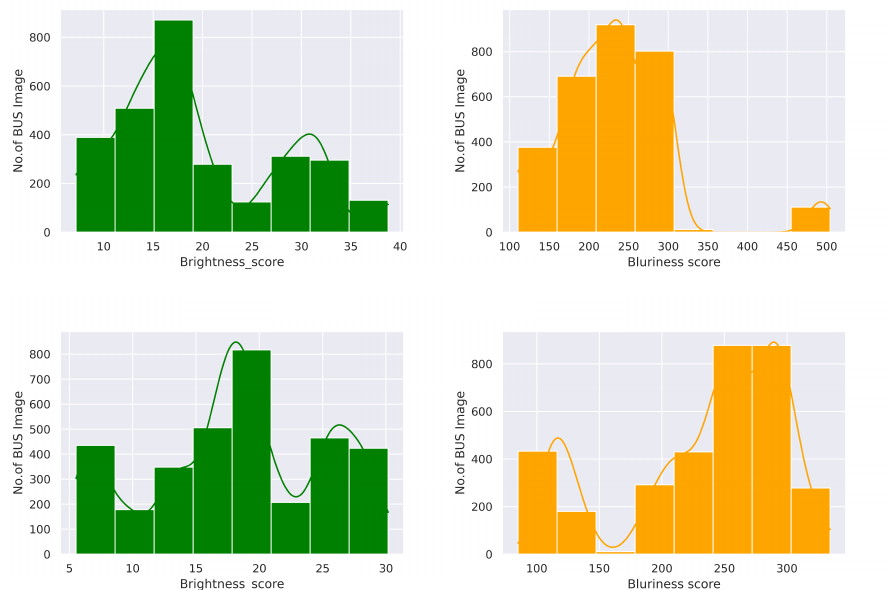
Figure 7. Brightness and blurriness scores analysis on the BUS sequence dataset. Top and below rows represent the benign and malignant classes, respectively. These plots were generated using the Python seaborn https://seaborn.pydata.org/ (accessed on 1 April 2022) and matplotlib https: //matplotlib.org/ (accessed on 1 April 2022)